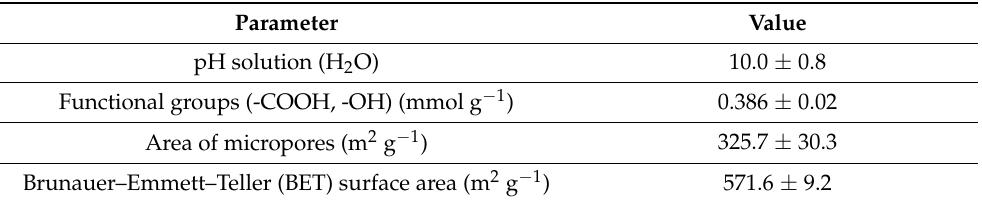
Table 2. Properties of biochar. Values represent means ± standard deviations ( n =